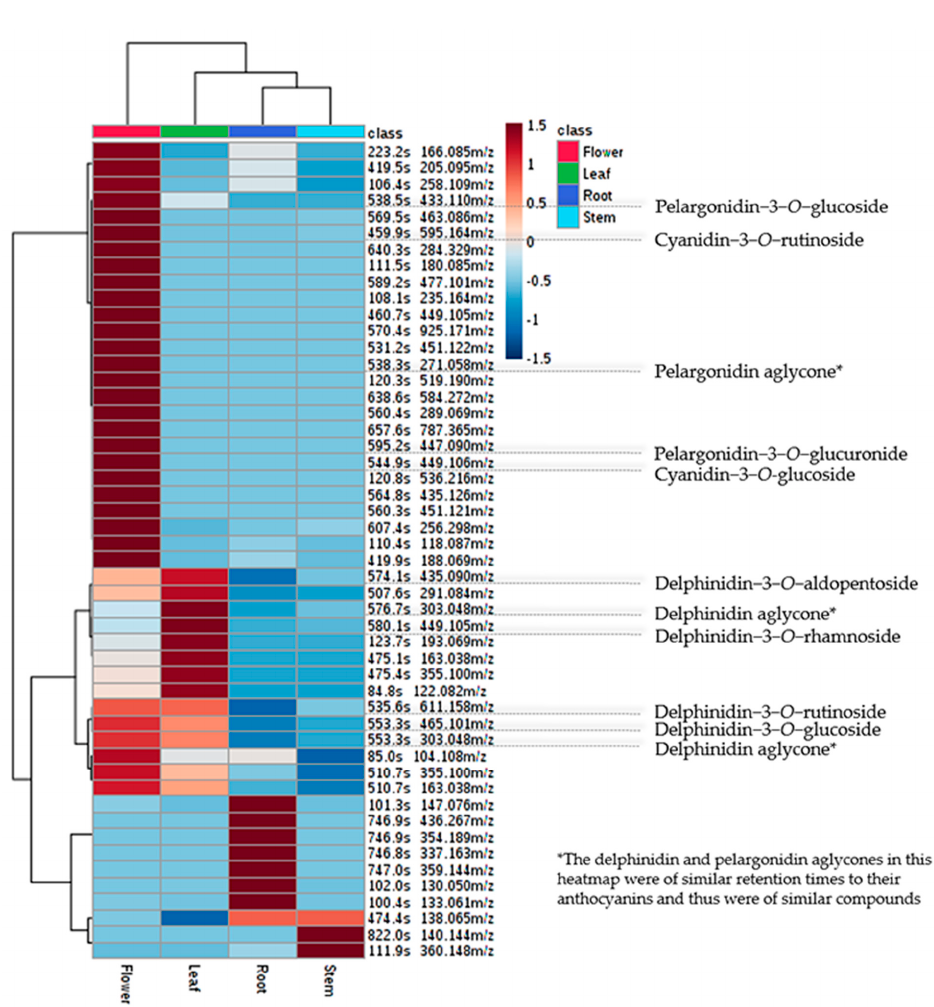
Figure 7. Heatmap of the most significant metabolites of different abundance levels marking the divergence between the flower, leaf, root, and stem tissues of C. caudatus. Anthocyanins in the heatmap are labelled, showing pelargonidin, cyanidin, and delphinidin derivatives in high abundance in flower tissue. In contrast, delphinidin derivatives were detected in high abundance in the leaf tissue compared to the stem and